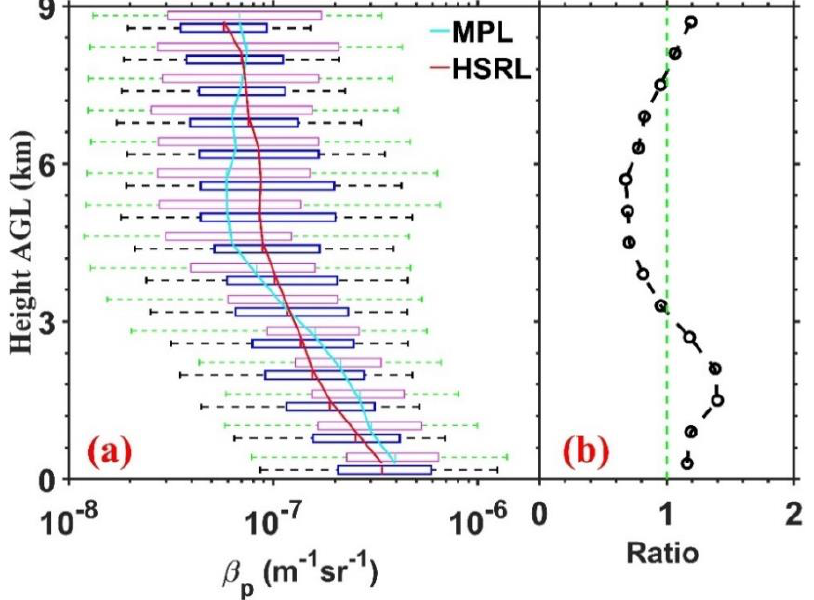
Figure 3. ( a ) The comparison of MPL (blue box) and HSRL (magenta box) backscatter coefficient vertical quartile distributions at the NSA site from January 2013 to September 2017. Box and whisker plots include the median, 25th and 75th percentiles (left and right of the boxes), and 5th and 95th percentiles (left and right of the whiskers). The red and cyan lines are for the medians of HSRL and MPL, respectively. ( b ) The ratio of MPL and HSRL backscatter medians.